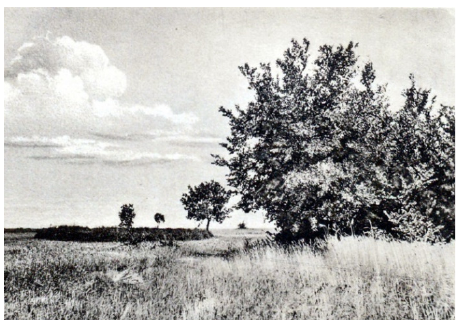
Figure 8. Extensions of forest and bushes on agricultural lands left barren during the First World War. View from the outskirts of Tuluce ş ti Forest [70].